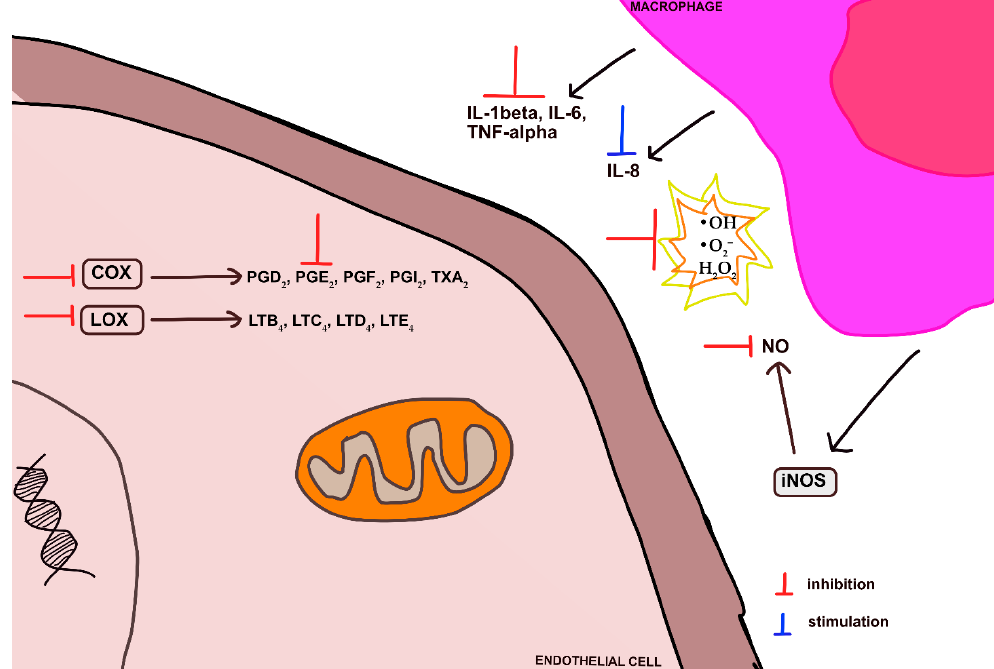
Figure 9. Mechanism of anti-inflammatory and antioxidant activity of Cuphea ex- tracts.